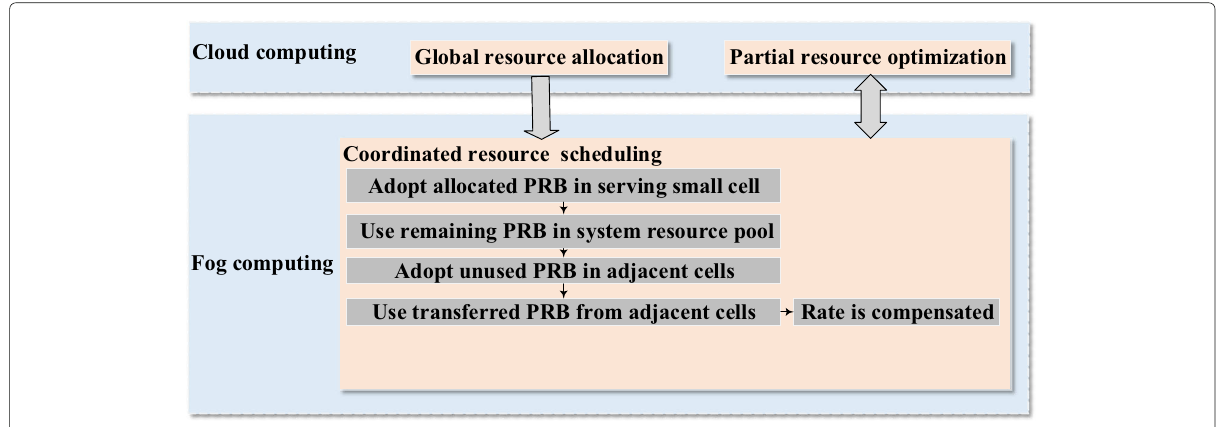
Fig. 2 Function block diagram of the proposed